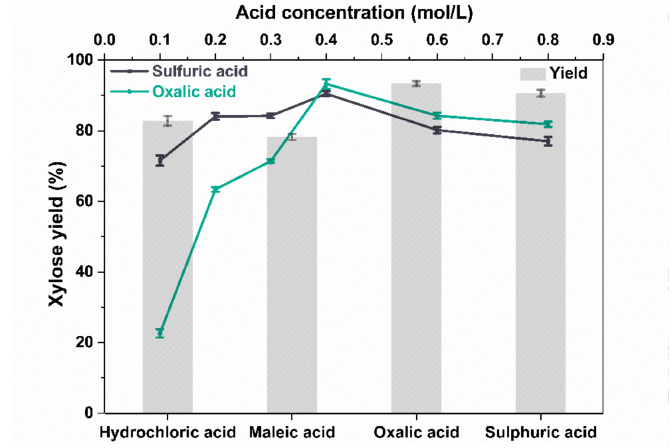
Figure 1. Effect of acid concentrations and types on xylose yield (120 ◦ C, 10 min, a solid–liquid ratio of 1:20; bar chart 0.4 mol/L; line chart 0.1–0.8